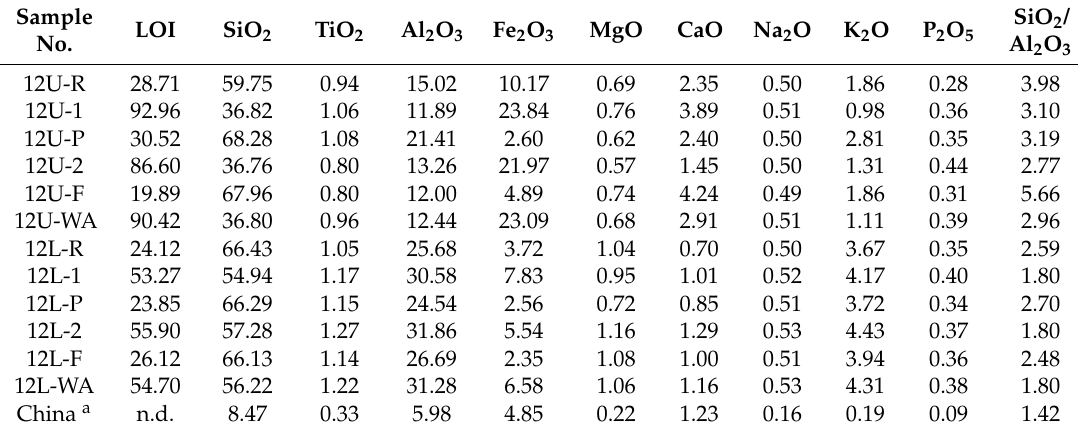
Table 2. Loss on ignition (LOI, %), and percentage of major oxide elements in samples from the Meitian Mine